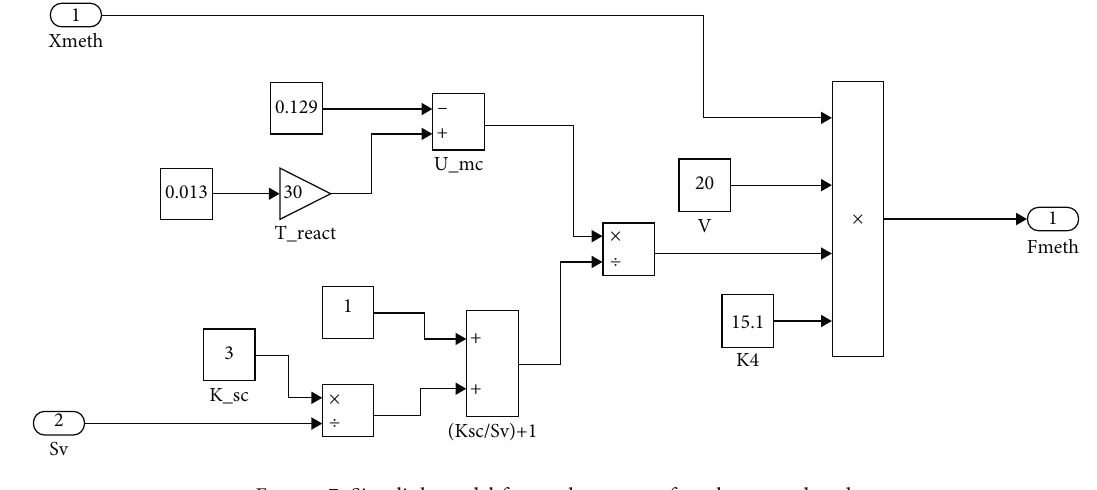
Figure 7: Simulink model for total amount of methane